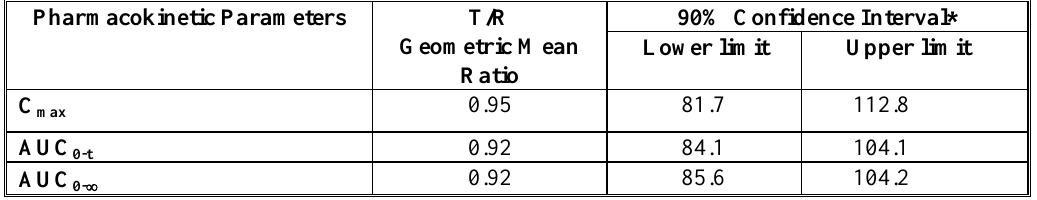
*Acceptance criteria = lower limit  80 and upper limit  125.0. Table (6): Geometric mean ratio and 90% Confidence Interval for the pharmacokinetic Parameters of the test versus the reference products in fed